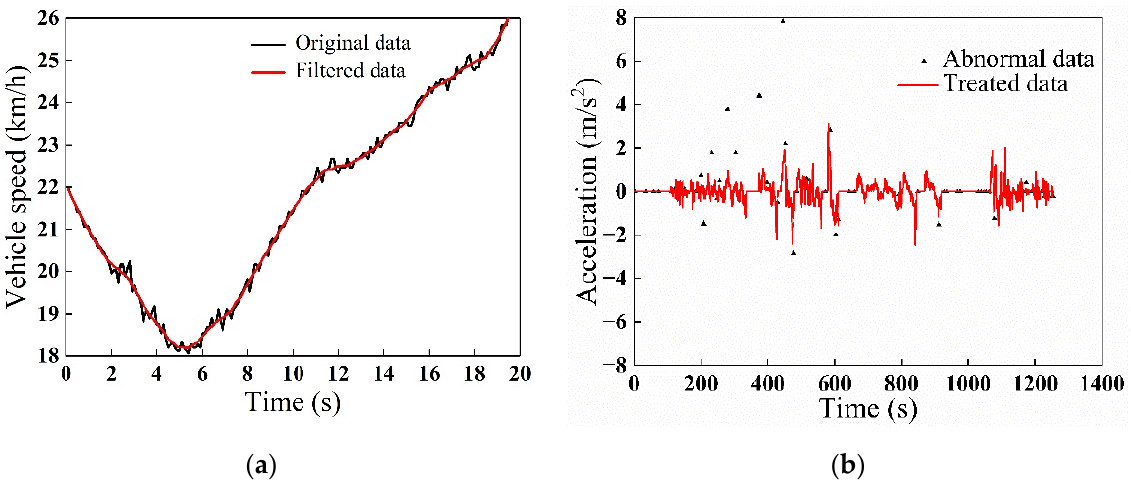
Figure 4. The comparison of the signal with different treat method: ( a ) Sliding-window averaging filter; ( b ) The box diagram method.